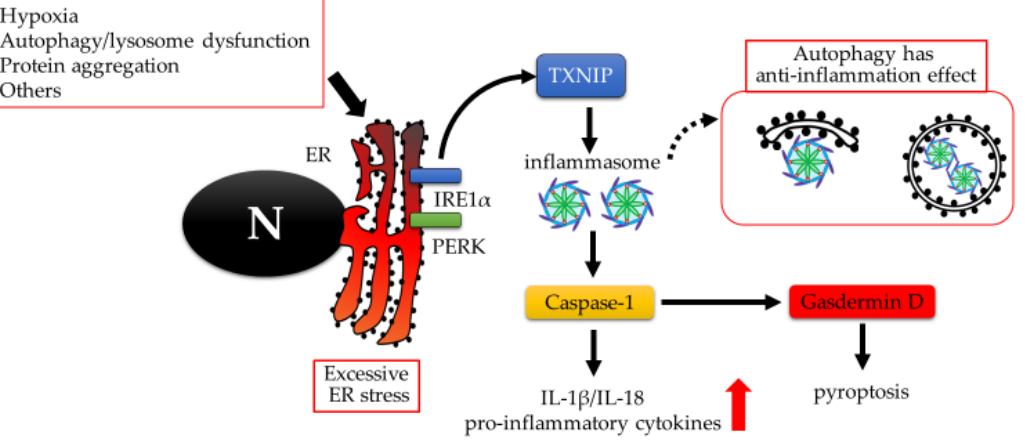
Figure 3. Excessive ER stress-mediated pyroptosis cascade. ER stress activates inflammasomes via Thioredoxin-interacting protein (TXNIP). Activated inflammasome increases the production of active caspase-1, which produces matured form of pro-inflammatory cytokines, IL-18 and IL-1β, and Gasdermin D. Finally, Gasdermin D leads to pyroptosis by forming pores in plasma membranes. Autophagy degrades inflammasome, resulting in preventing inflammation. On the contrary, impaired autophagy may trigger pyroptosis. N: